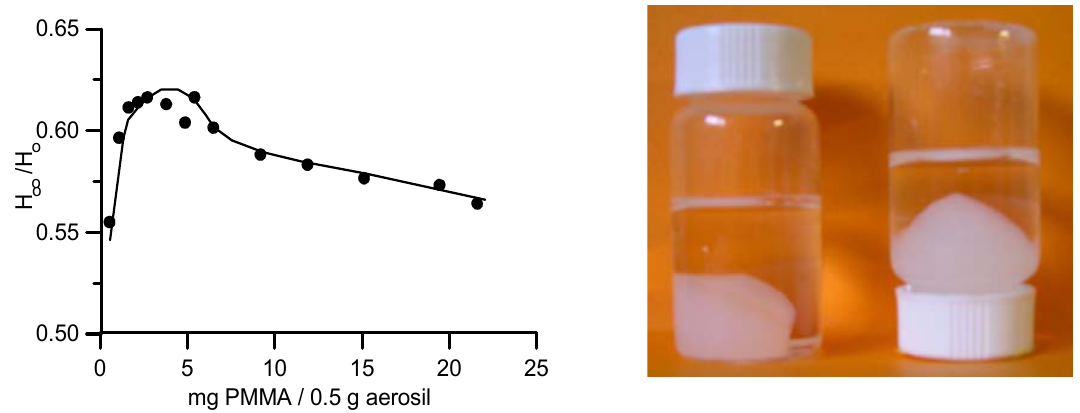
Figure 2. Representation of the relative height of the sediment as a function of the amount of polymethylmethacrylate (PMMA) polymer supplied to 0.5 g aerosil suspended in 15 mL methylmethacrylate monomer ( left ). Representation of two unusually stable forms of settled sediment for the system (0.5 g aerosil/15 mL methylmethacrylate/4.32 mg PMMA) corresponding to the maximal H /H value ( right ∞ 0